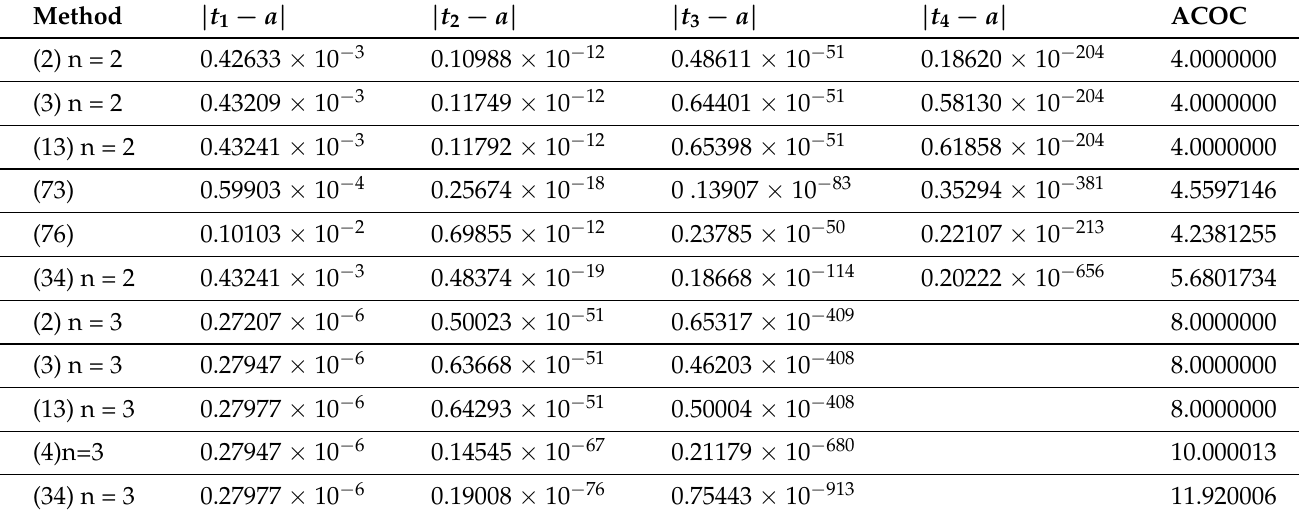
Table 8. Numerical results for f 3 ( t ) .